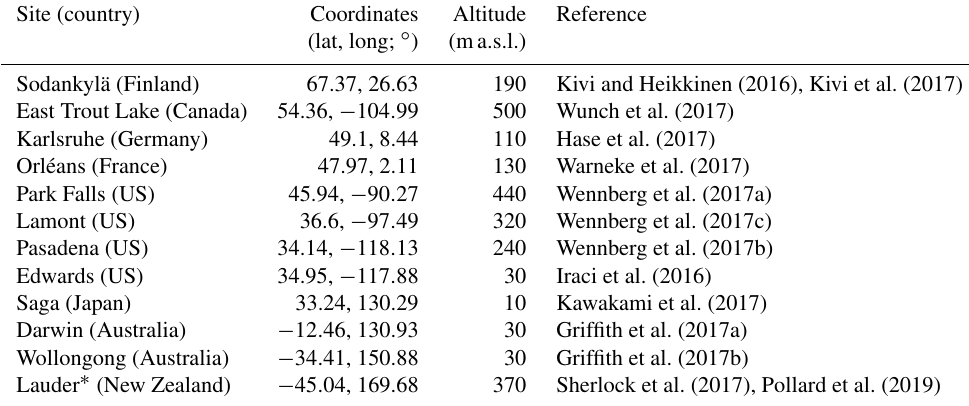
Table B2. Overview of the stations from the TCCON network used for validation of land measurements in Sect.